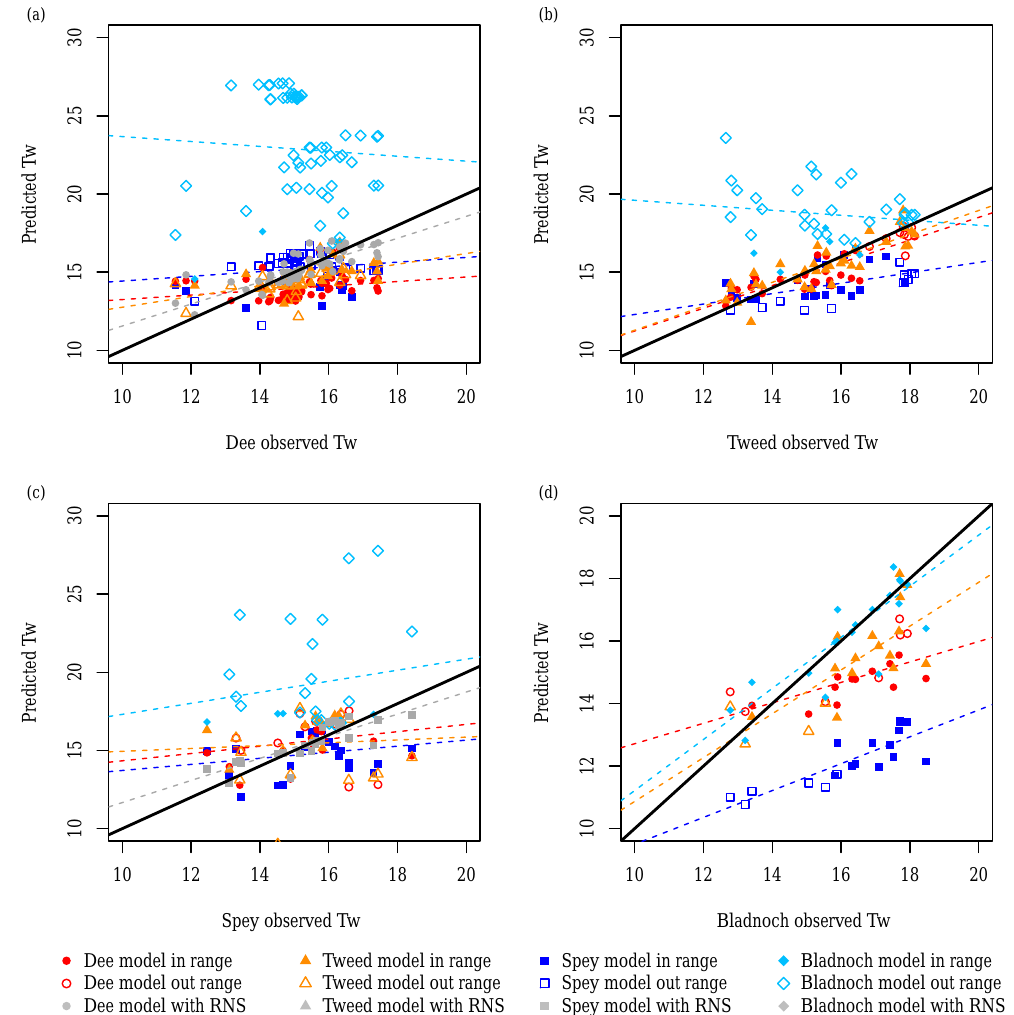
Figure 6. LS_ T a model transferability. Panels (a) , (b) , (c) and (d) show predicted T w when the target catchment is the Dee, Tweed, Spey max and Bladnoch, respectively. The colours and symbols indicate the donor catchment: Dee (red circles), Tweed (orange triangles), Spey (dark blue squares) and Bladnoch (light blue diamonds). Filled (open) symbols indicate sites in (out) of the environmental range of the donor catchment. When the target and donor catchments are the same, the coloured points are based on predictions using only covariates; the grey symbols show the corresponding predictions based on the covariates and the RNS. The dashed lines are robust regression lines of observed against predicted values. Models which transfer well have points falling close to the 1 : 1 line. explain less of the variance than in the single-catchment models (Tables 3,